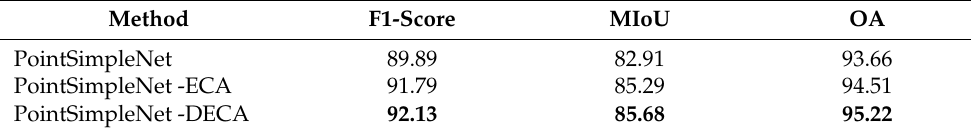
Table 6. Quantitative evaluation of the DECA module through three groups of comparative experi- ments (%) on the OCS point cloud dataset. The best metrics are highlighted in bold. Method F1-Score MIoU OA PointSimpleNet 89.89 PointSimpleNet -ECA 91.79 PointSimpleNet -DECA 95.22